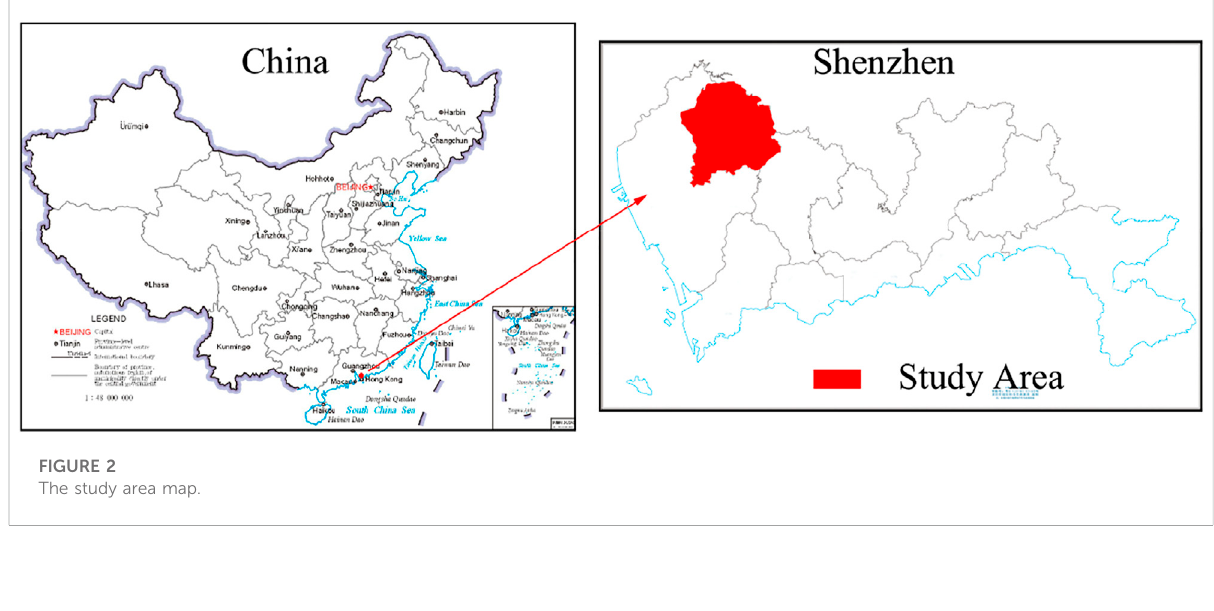
TABLE 3 Experimental image sample